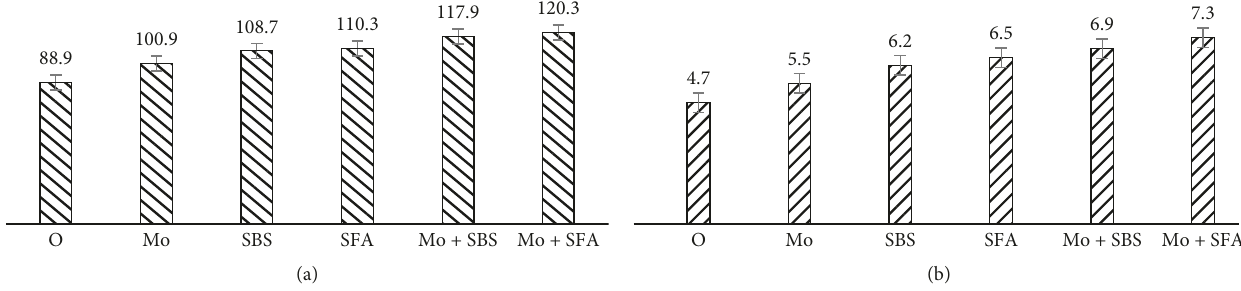
Figure 2: The influence of Mo and S application on the (a) nitrogen uptake (kg · N · ha − 1 ) and (b) sulphur uptake (kg · S · ha − 1 ) (mean for 2012–2014).